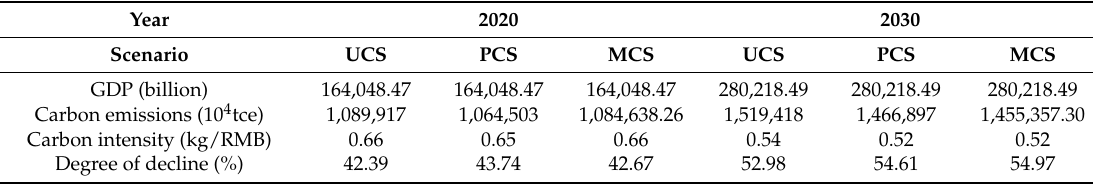
Table 7. Energy structure optimization results under various